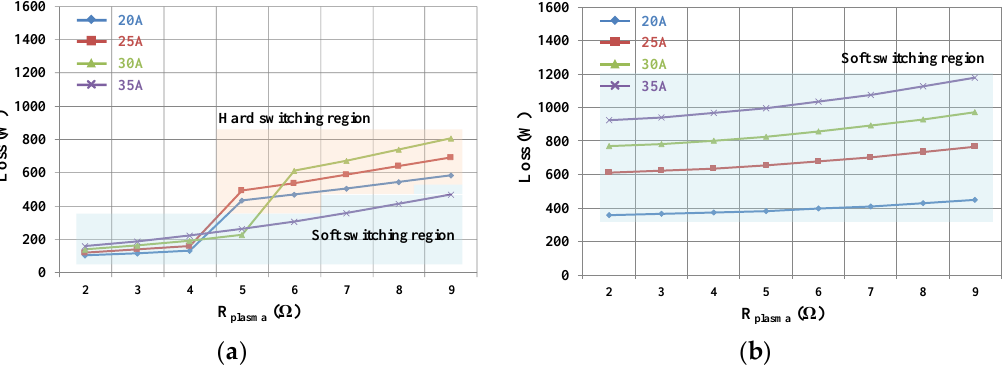
Figure 9. Loss analysis of each resonant network: ( a ) loss according to load variation in the LCL network; ( b ) loss according to load variation in the LCCL network.